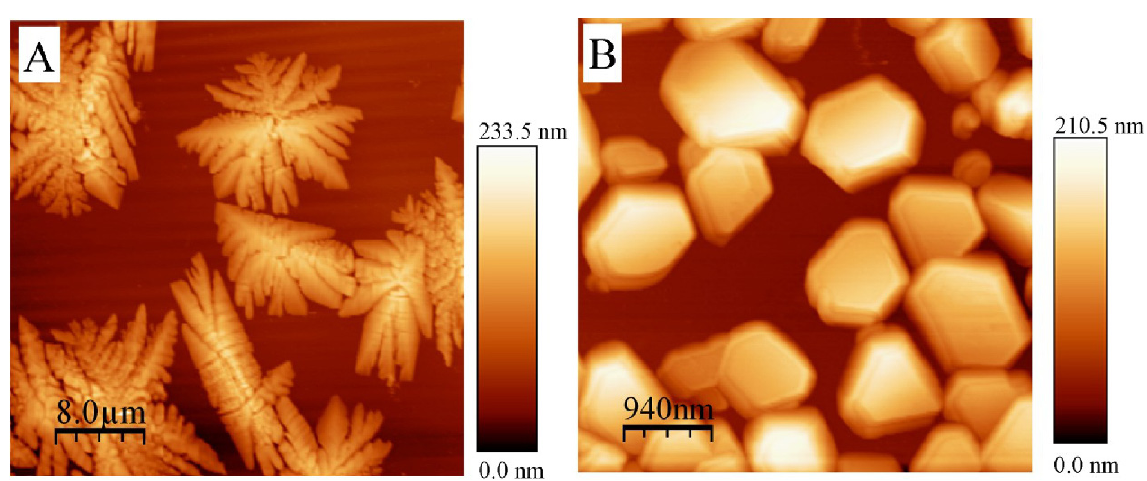
Figure 6. Vacuum deposited PTEN film with ∼ 200 µm thickness at: A) flux rate of 0.03 nm/s; and B) flux rate of 0.25